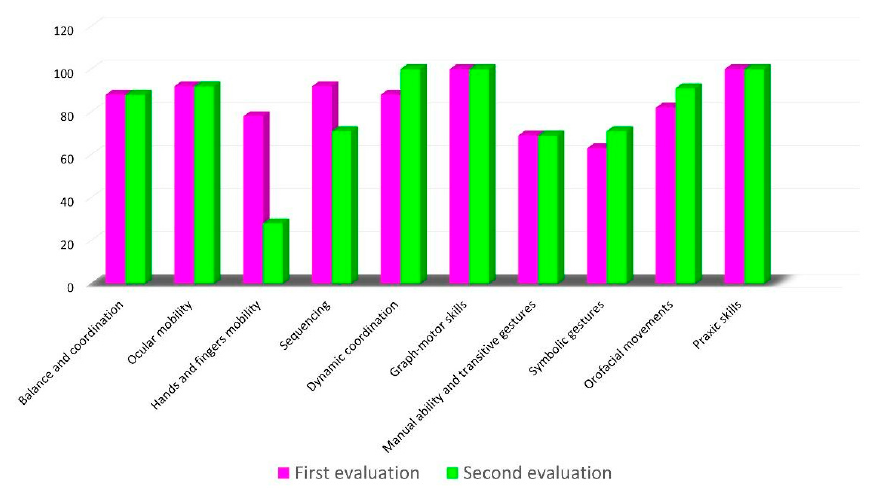
Figure 6. Dyspraxia-related aspects on control subjects. Comparison between first and second Abilità Prassiche e della Coordinazione Motoria—2a Edizione (APCM-2) APCM-2 evaluations (average values on all five control subjects).